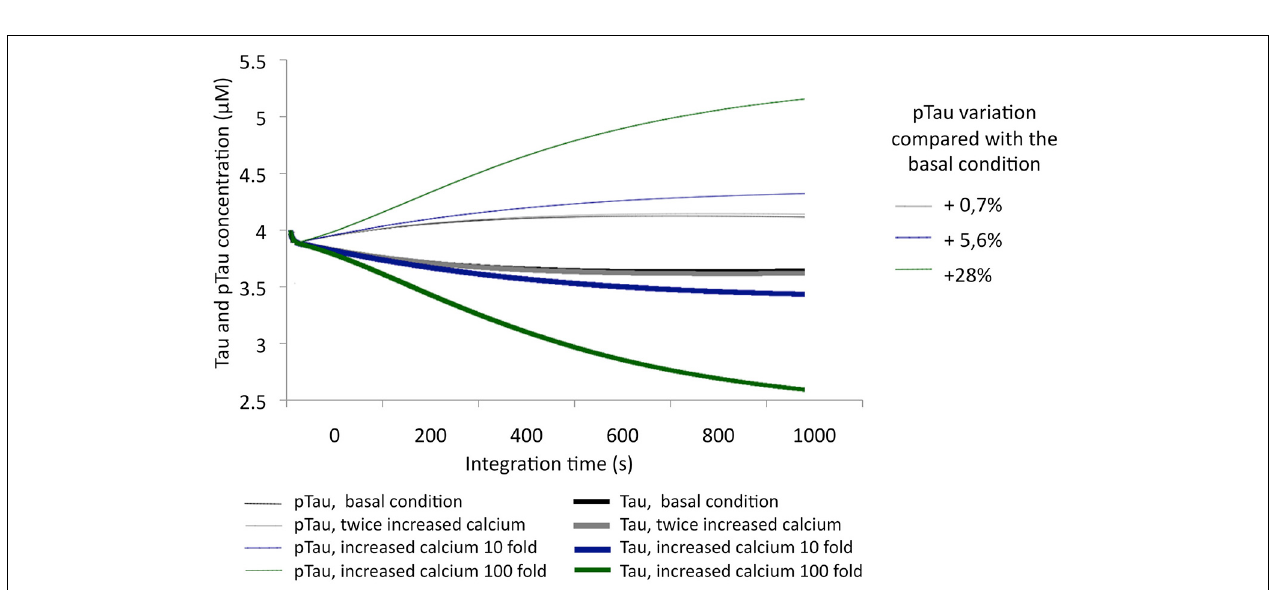
FIGURE 3 | Variation in the levels of Tau and pTau after KOis of CDK5, GSK3 β , PP2A, and PP1. K2 was modified, which decreased this value by 100%. The inset in the figure indicates pTau variation compared with the basal condition.